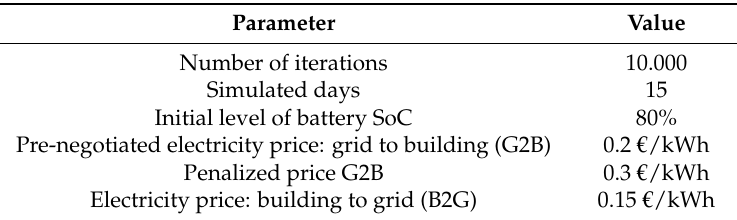
Table 2. Parameters of Monte Carlo